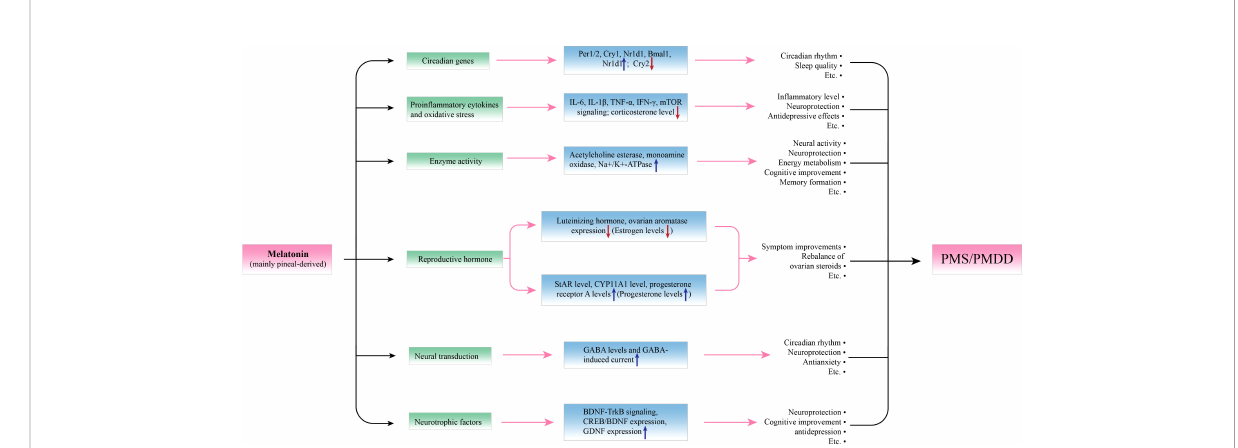
FIGURE 2 Potential molecular actions of melatonin in modulating premenstrual symptoms. By affecting the expression of relevant molecules, and melatonin can achieve its protective effects in PMS. Per1/2, Cry1/2, and Nr1d1 are circadian genes, melatonin can upregulate their expression to improve circadian rhythm and sleep quality. IL-6, IL-1 b , TNF- a , IFN- g , and mTOR signaling pathways and increased corticosterone levels participate in the in fl ammation and oxidative stress of PMS, and melatonin can downregulate these processes to play a role in neuroprotection and antidepression. Regarding enzyme activity, melatonin can upregulate the activity of acetylcholine esterase, monoamine oxidase, and Na+/K+-ATPase to promote neural activity, energy metabolism, cognition, and so on. An imbalance of reproductive hormone is seen as a pathogenesis of PMS, melatonin can